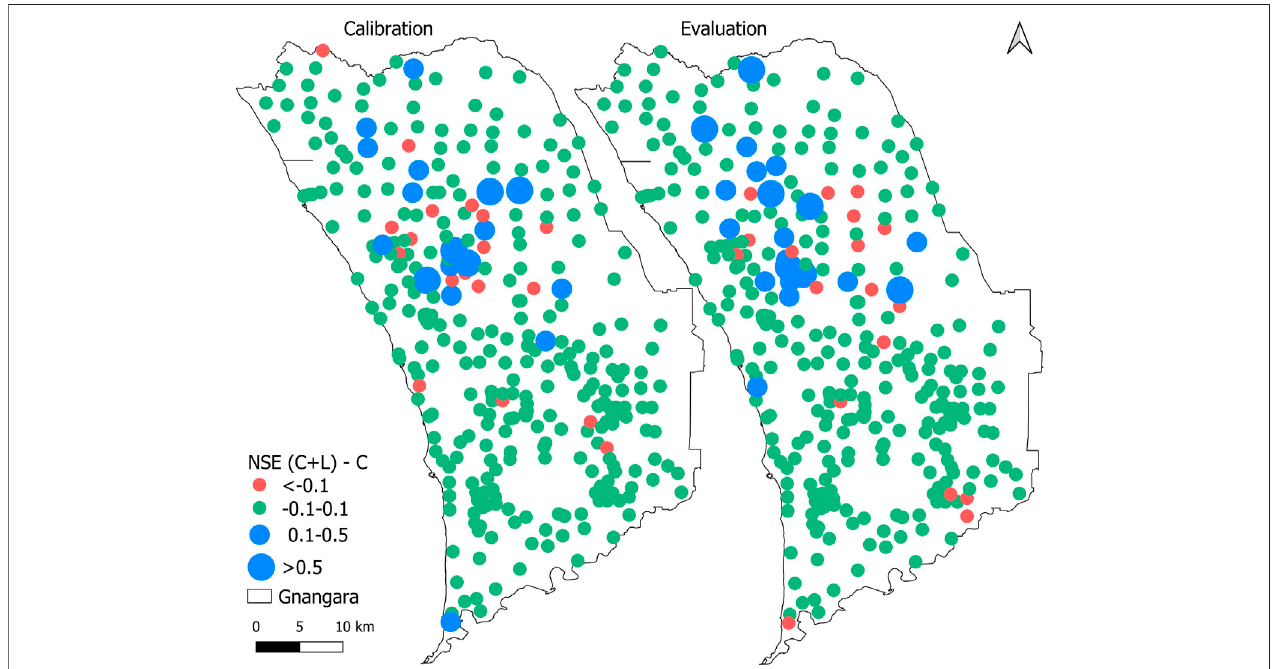
FIGURE 5 | Difference in NSE between the climate-only (C) analysis and the climate and land cover (C + L) analysis.